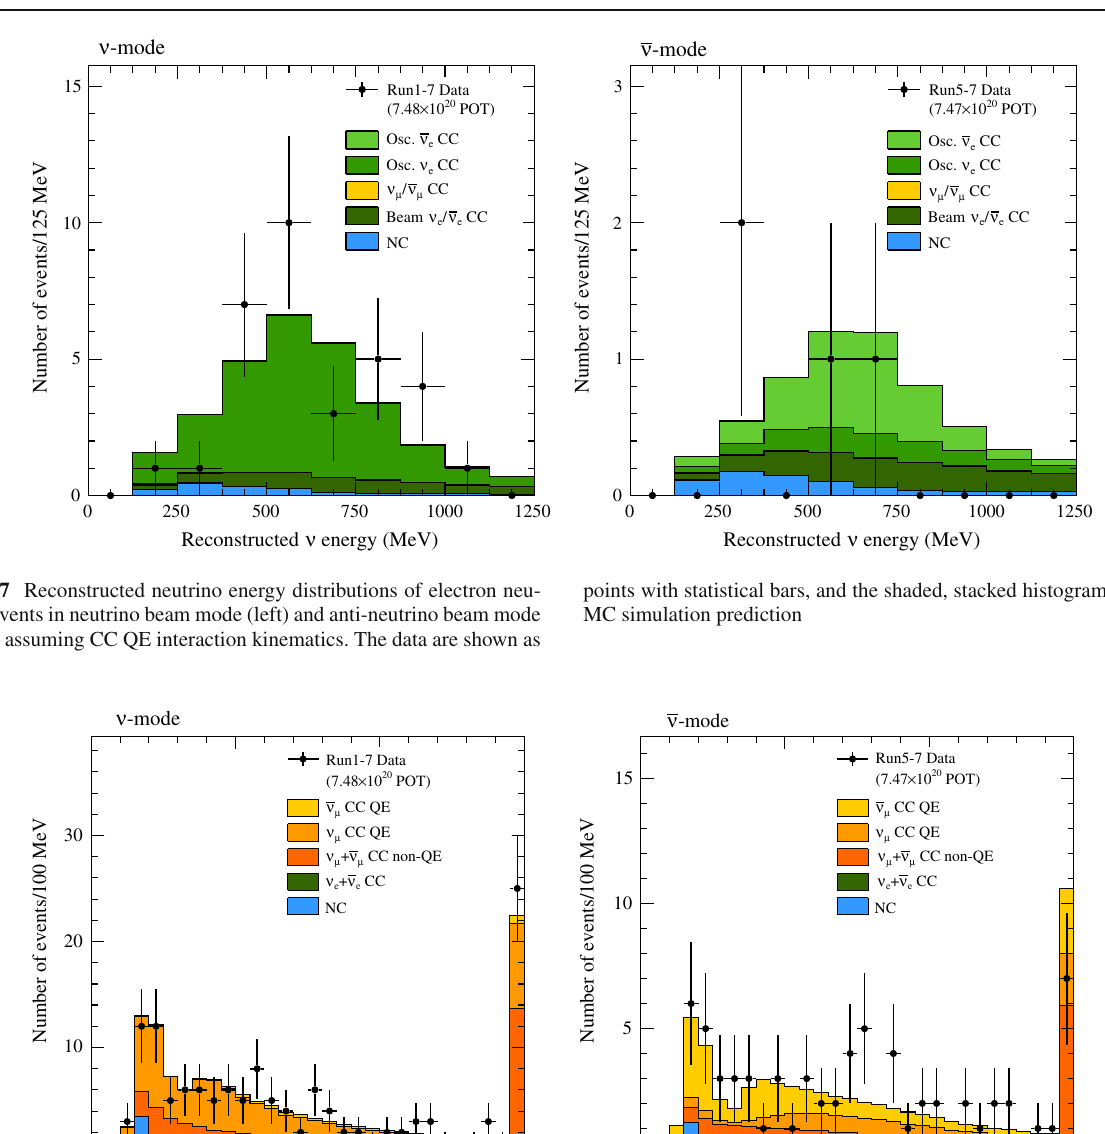
with statistical bars, and the shaded, stacked histograms are the MC simulation prediction